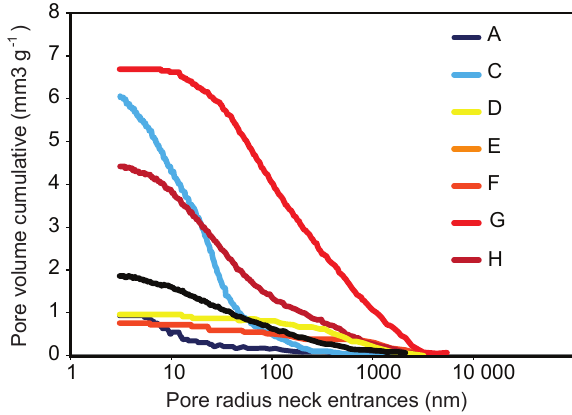
Figure 13. Results from multicycle MIP experiments. Pore radius of the neck entrances vs. cumulative pore